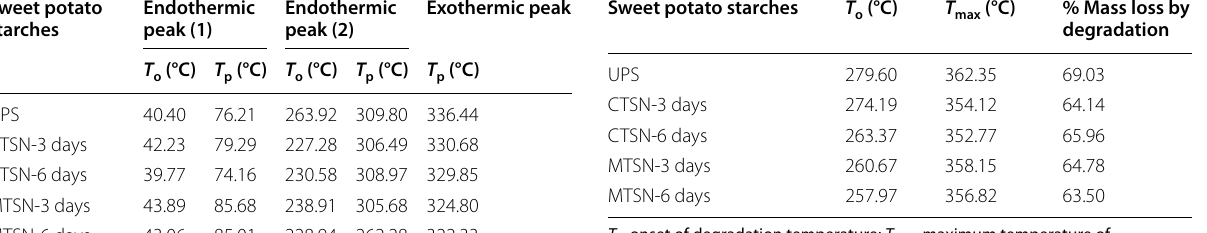
MTSN-6 days 228.94 262.28 322.33 Gelatinization temperature parameters (in °C) temperature ( T p )